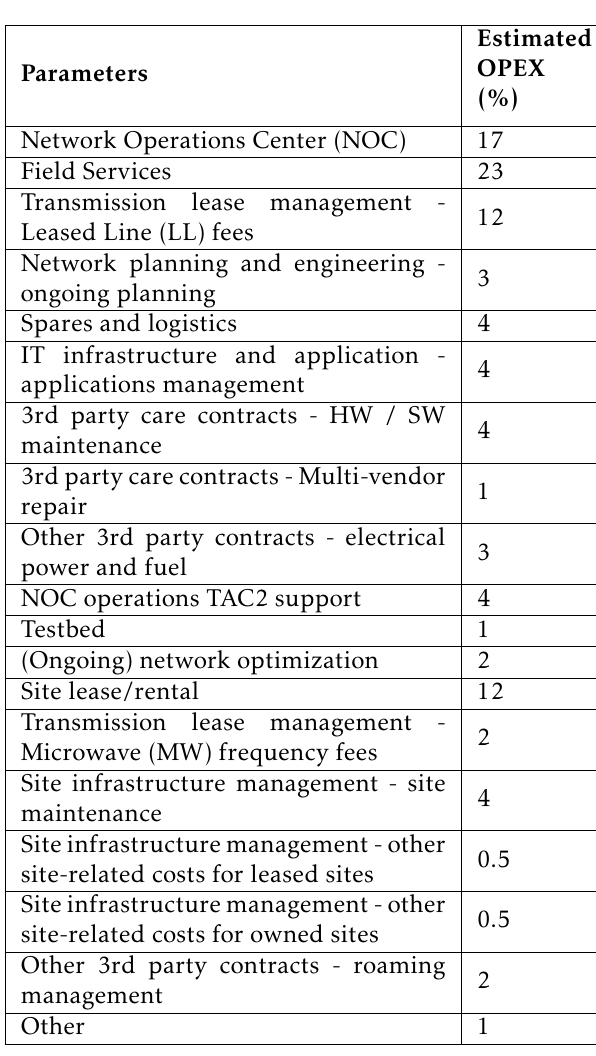
Table 2. OPEX analysis for mobile network